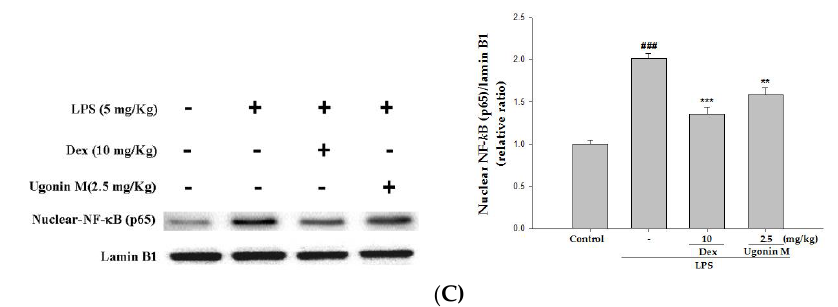
Figure 9. Effects of Ugonin M on LPS-induced: ( A ) MAPK phosphorylation and non-phosphorylation protein expressions; ( B ) cytosolic IκB-α and NF-κB; and ( C ) nuclear NF-κB concentrations in ALI mice. Tissue suspended were then prepared and subjected to Western blotting. Data represent the mean ± SD for three different experiments performed in triplicate. ### p < 0.001 was compared with a sample of the control group (One-way ANOVA followed by Scheffe’s multiple range tests). ** p < 0.01 and *** p < 0.001 were compared with the LPS-only group.